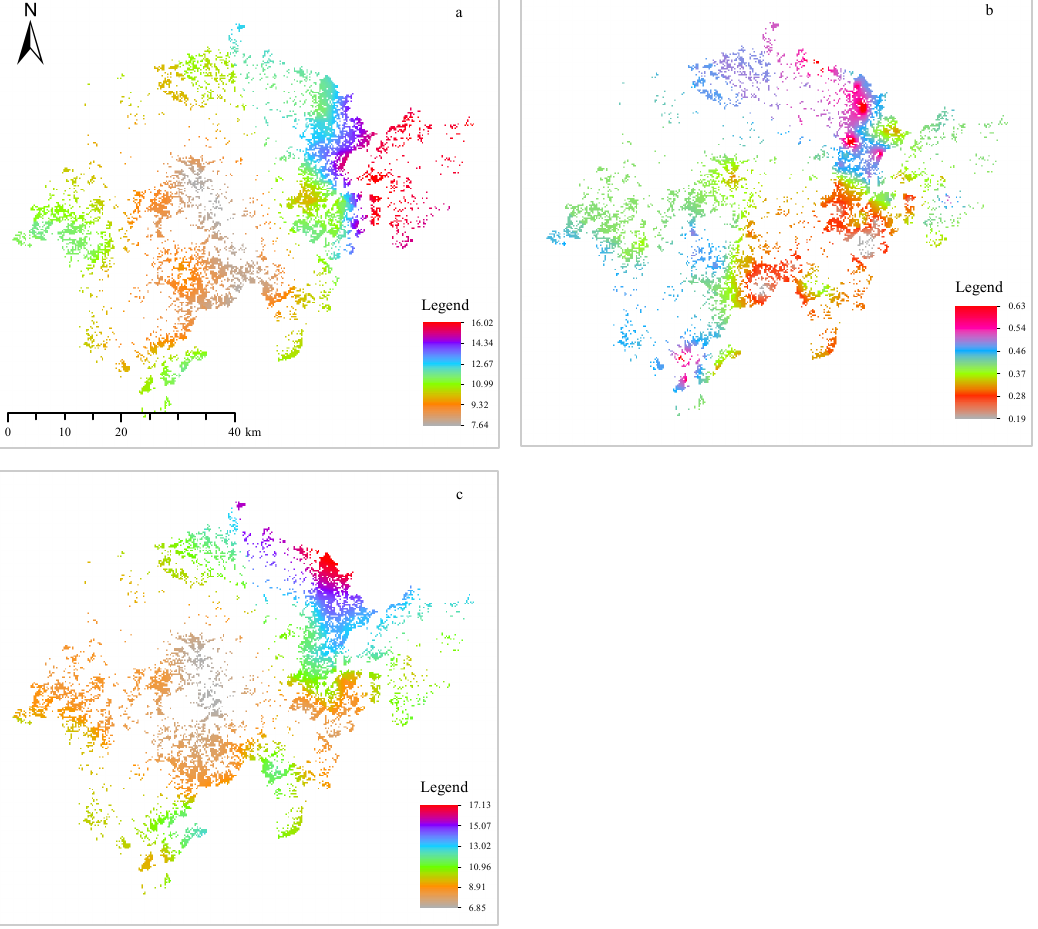
Figure 4. Spatial distribution of soil N ( a ), P ( b ), and K ( c )